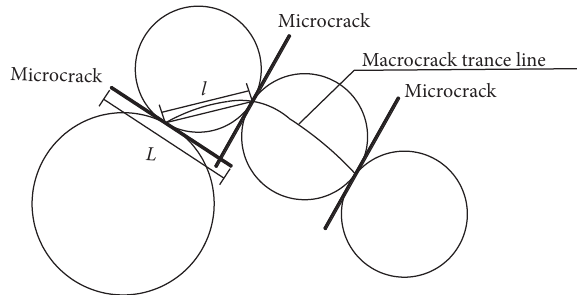
Figure 3: Constructing a macrocrack based on connecting cen- troids of microcracks